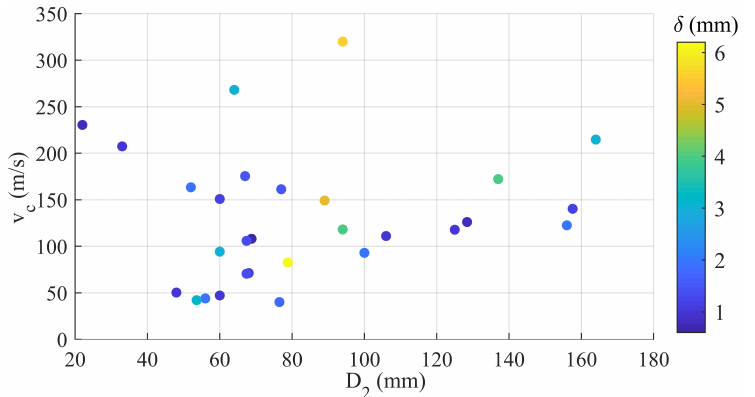
Figure 14. Common values of air gap length for different rotor outside diameters and different linear